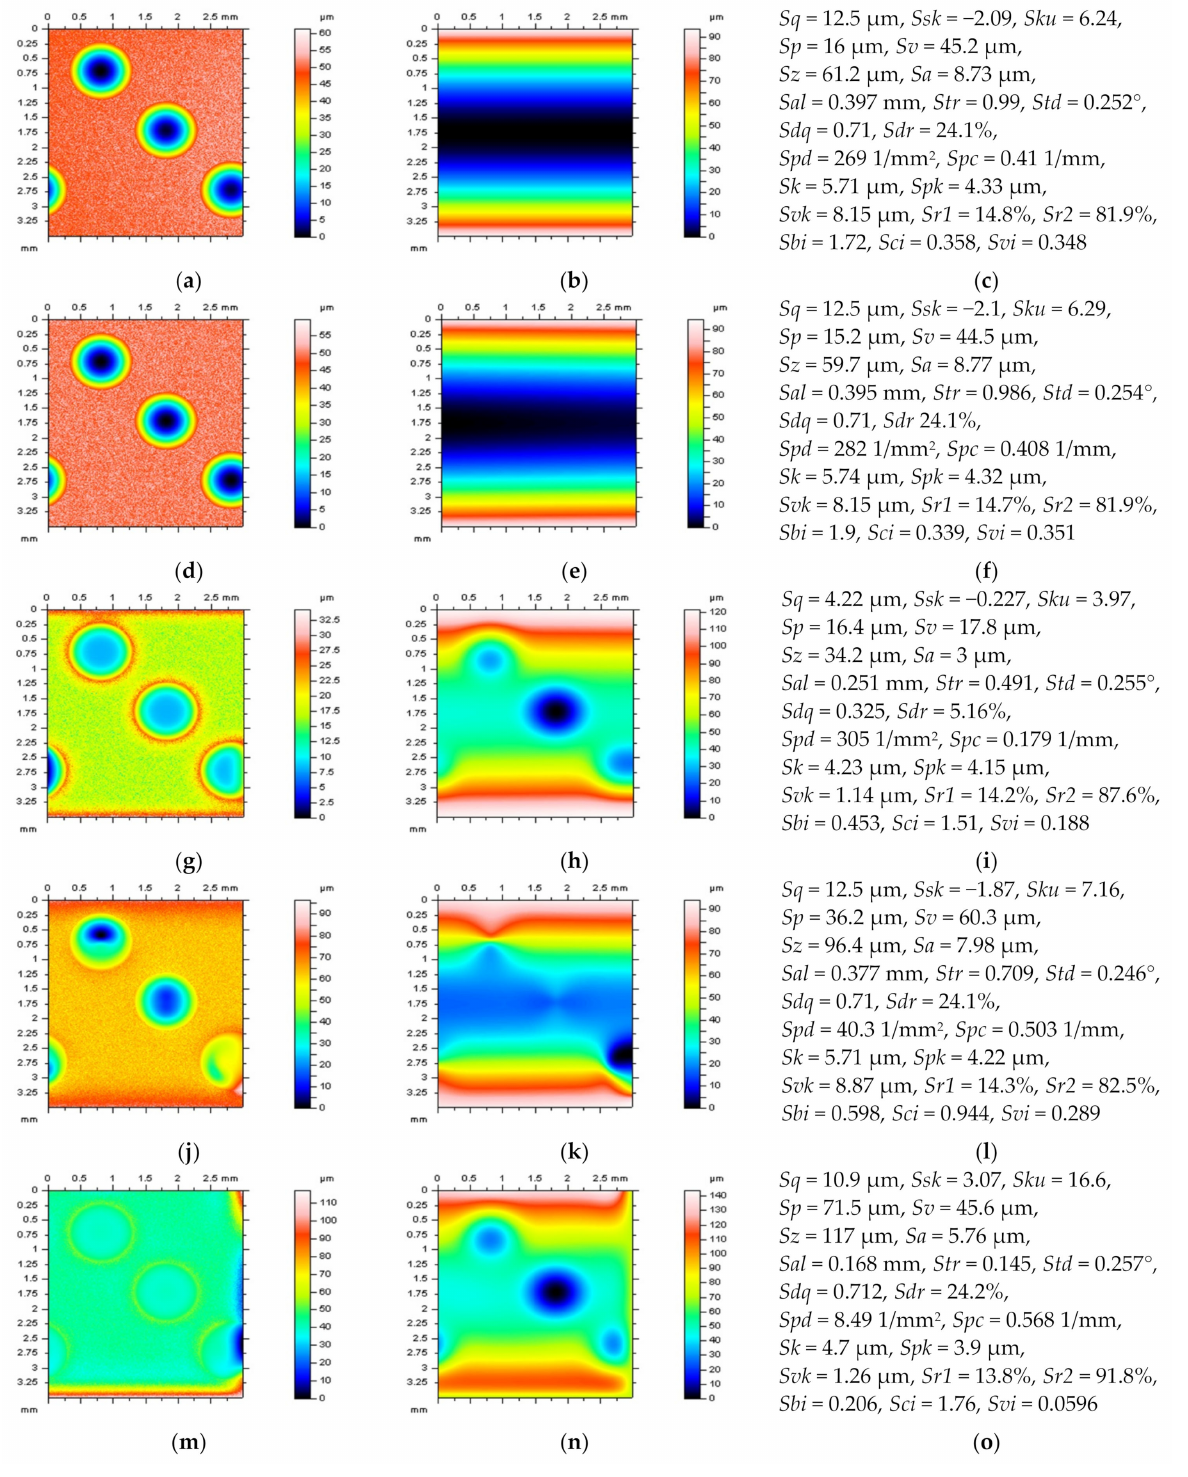
Figure 3. Contour map plots of the surface after the areal form removal (left column), reference planes (middle), and ISO 25178 parameters (right column), obtained from an isotropic cylindrical surface with wide and deep dimples, after the application of LSFC ( a – c ), POLY4 ( d – f ), GRF ( g – i ), RGRF ( j – l ), and SF ( m – o ), cutoff = 0.8